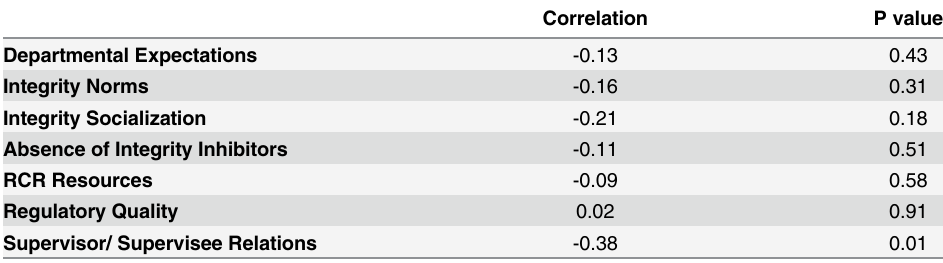
Table 2. Correlations between facility means and facility participation